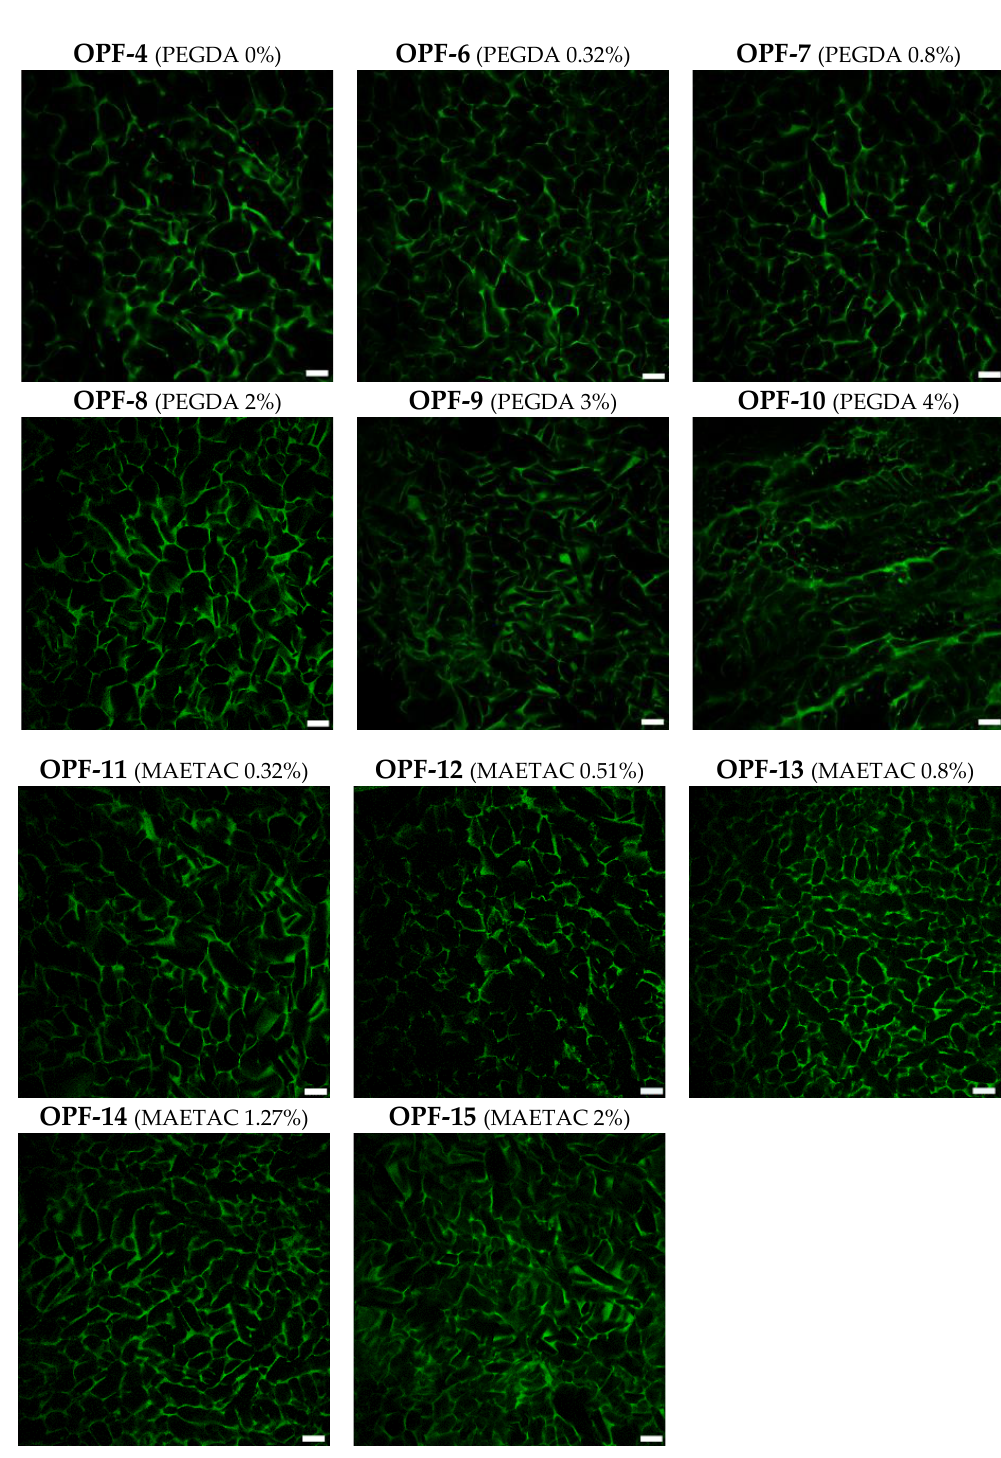
Figure 3. ( A ) The swelling properties of OPF cryogels (OPF 4 wt.%) with an increased amount of PEGDA (OPF-4 – OPF-10) or OPF/PEGDA cryogels (OPF 4 wt.%, PEGDA 2 wt.%) with an increased amount of MAETAC (OPF-11 – OPF-15). The mass content of capillary water (CW) and polymer- bound water (PW) is shown (mean ± SD, n = 3). ( B ) LSCM images of OPF cryogels are visualized by autofluorescence upon argon laser excitation (514 nm). The variable amounts (wt.%) of PEGDA and MAETAC are shown in parentheses. Scale bar 100 µm.